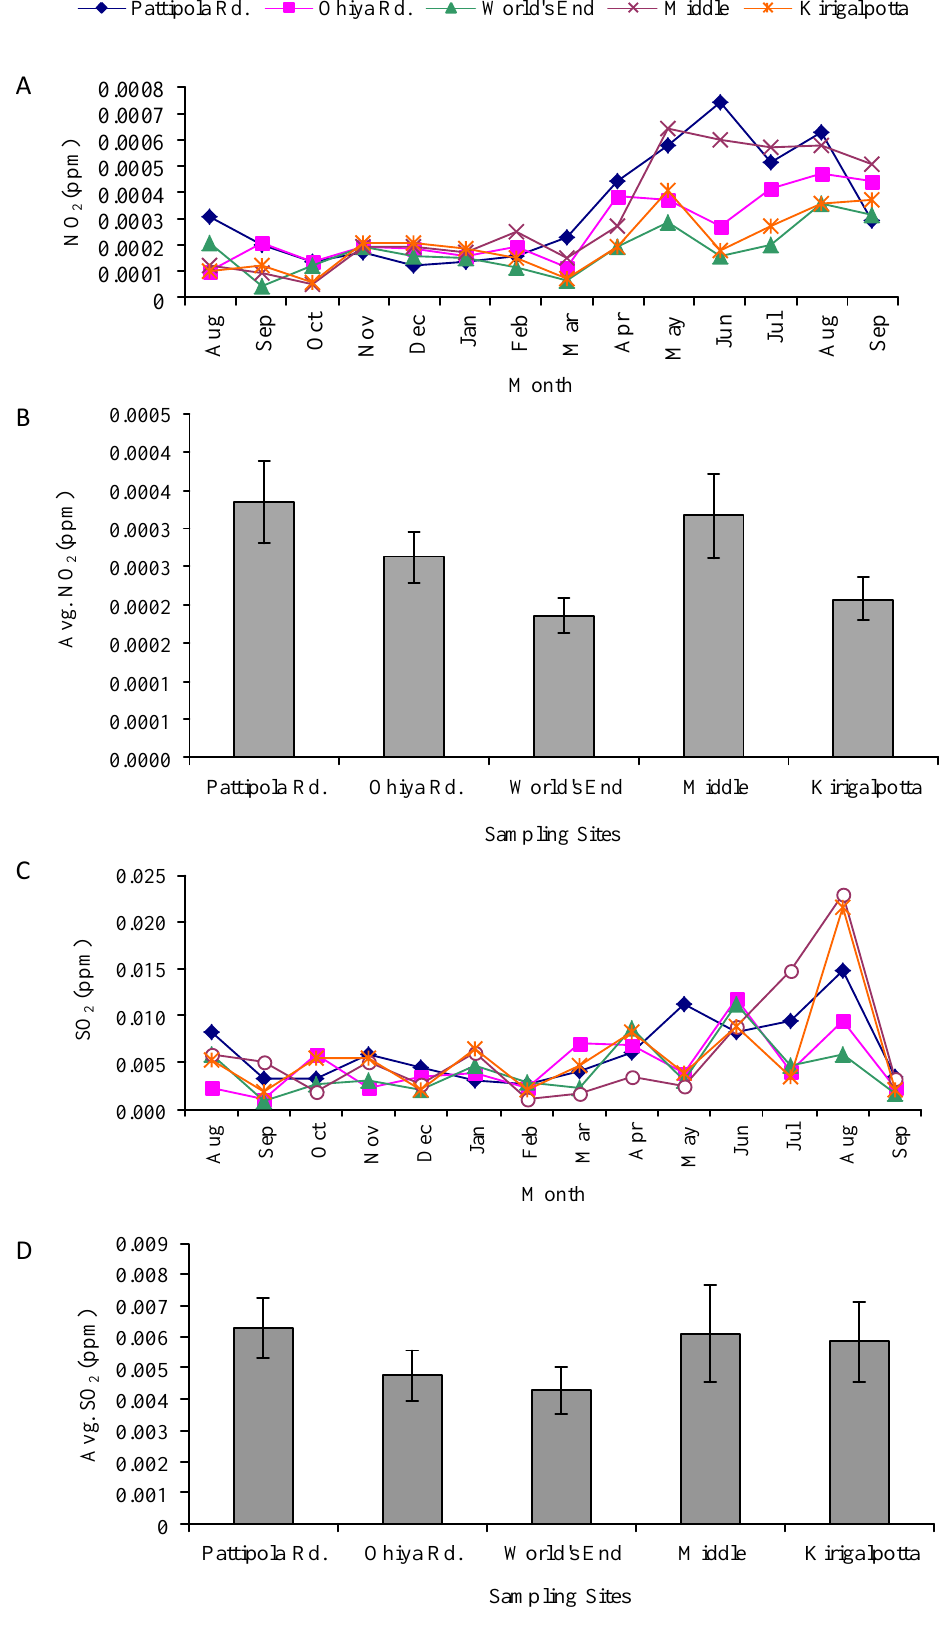
Figure 2: Variation of 24 h average ambient concentrations of NO 2 (A) and SO 2 (C) over the period of 12 months and average concentrations of NO 2 (B) and SO 2 (D) in each sampling